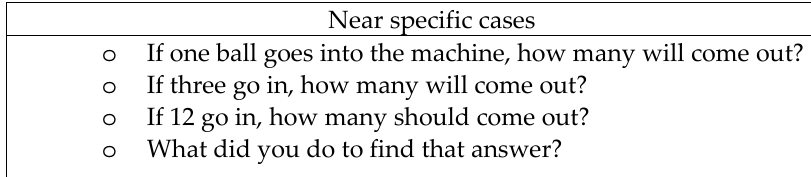
Figure 5. Near specific cases used in the interview.